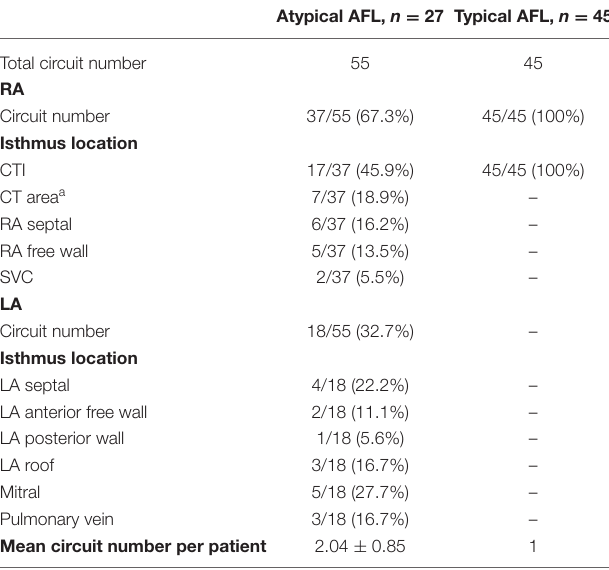
TABLE 2 | The circuit number and the location of the isthmus of AFL in our study